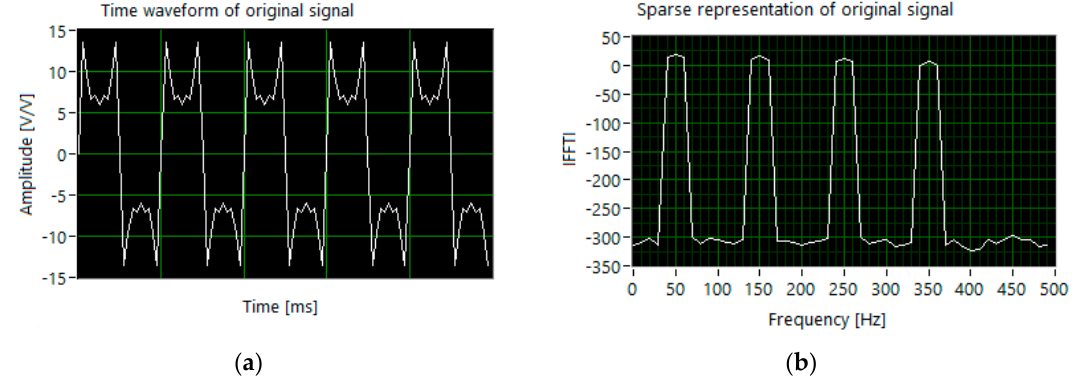
Figure 4. The results of simulation for set 1: ( a ) the segment of time waveform; ( b ) discrete Fourier transform (DFT) components of input